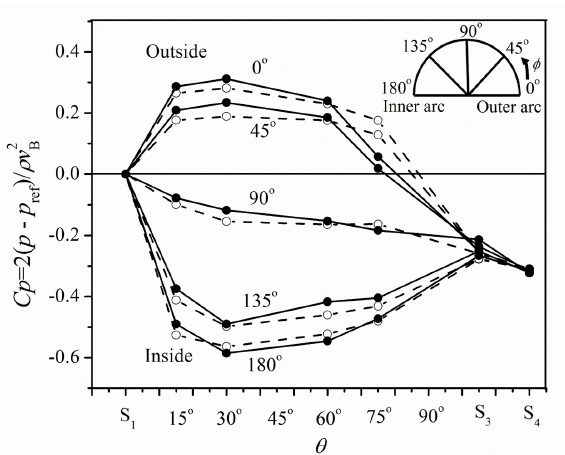
Figure 10. Variation of the wall static pressure along the inner and outer arc of the bend at Re = 43,000. The numerically calculated values (filled dots) are compared with Enayet et al.’s [1] experimental measurements (open circles). The data are taken at station S 1 upstream of the bend inlet, at angles θ = 15 ◦ , 30 ◦ , 60 ◦ and 75 ◦ in the bend and at stations S 3 and S 4 downstream of the bend outlet for azimuthal angles φ = 0 ◦ , 45 ◦ , 90 ◦ , 135 ◦ and 180 ◦ on the circular wall of the